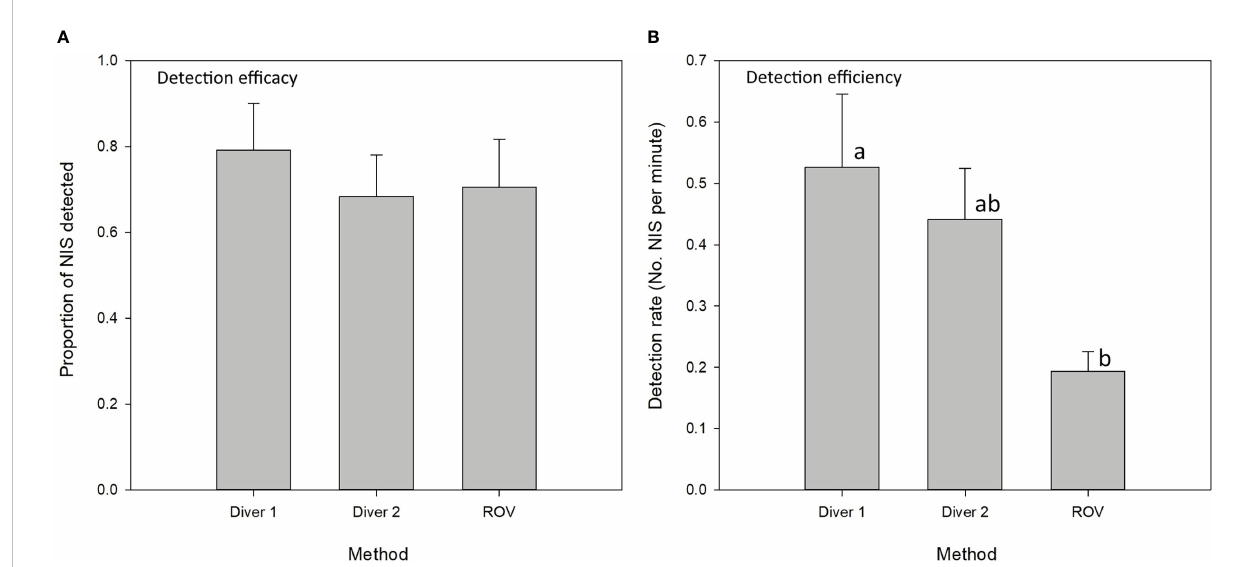
FIGURE 4 Comparison of SCUBA divers and ROV for NIS detection. Graph (A) shows the proportion of NIS detected at each site (detection ef fi cacy) and graph (B) shows the detection rate per minute for each method (detection ef fi ciency). Results of Tukey test comparisons shown by letters (a, b), with separate letters indicating statistically signi fi cant differences.